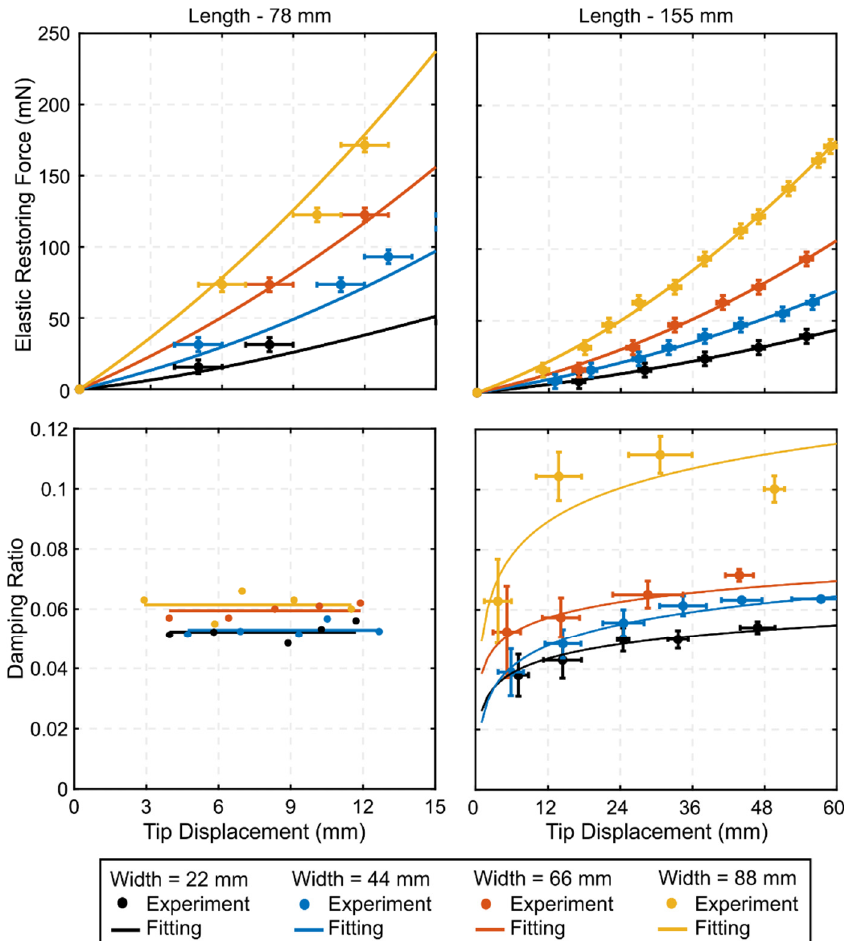
Figure 3. Measured elastic restoring force ( top ) and damping ratio ( bottom ) of the harvesters (the continuous lines are fitting lines included to help visualize the trend in the data). Markers represent the measured quantities from the experimental tests, error bars in the top panels reflect the measuring errors in the elastic restoring force and tip displacement (as discussed in Appendix A), whereas those in the bottom-right panel represent the standard deviation of repeated measures.